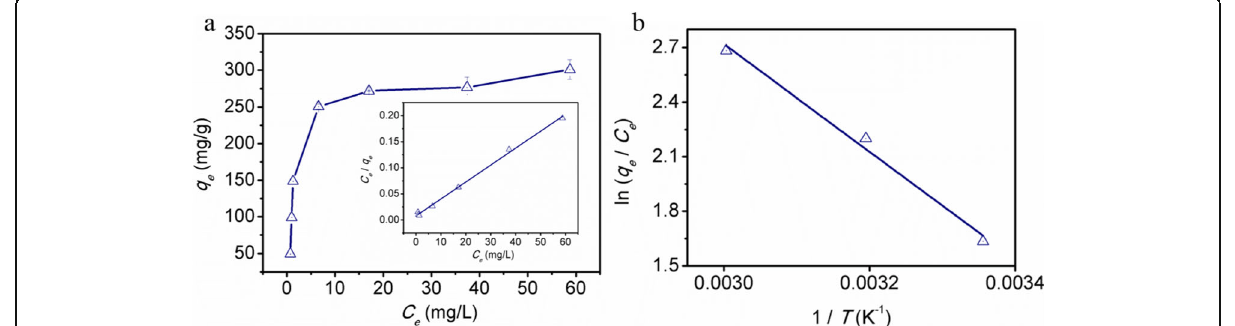
Fig. 3 a PPMs ’ adsorption isotherms to Cr(VI) at 298 K (Inset: Linear Langmuir model); b the plots of ln K a versus of 1/ T